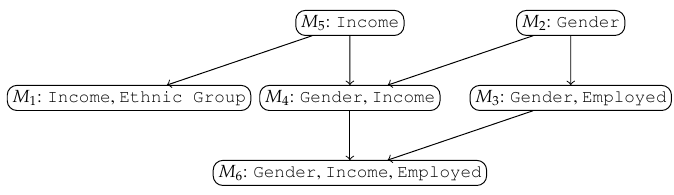
Figure 2. Example of a hierarchy of models